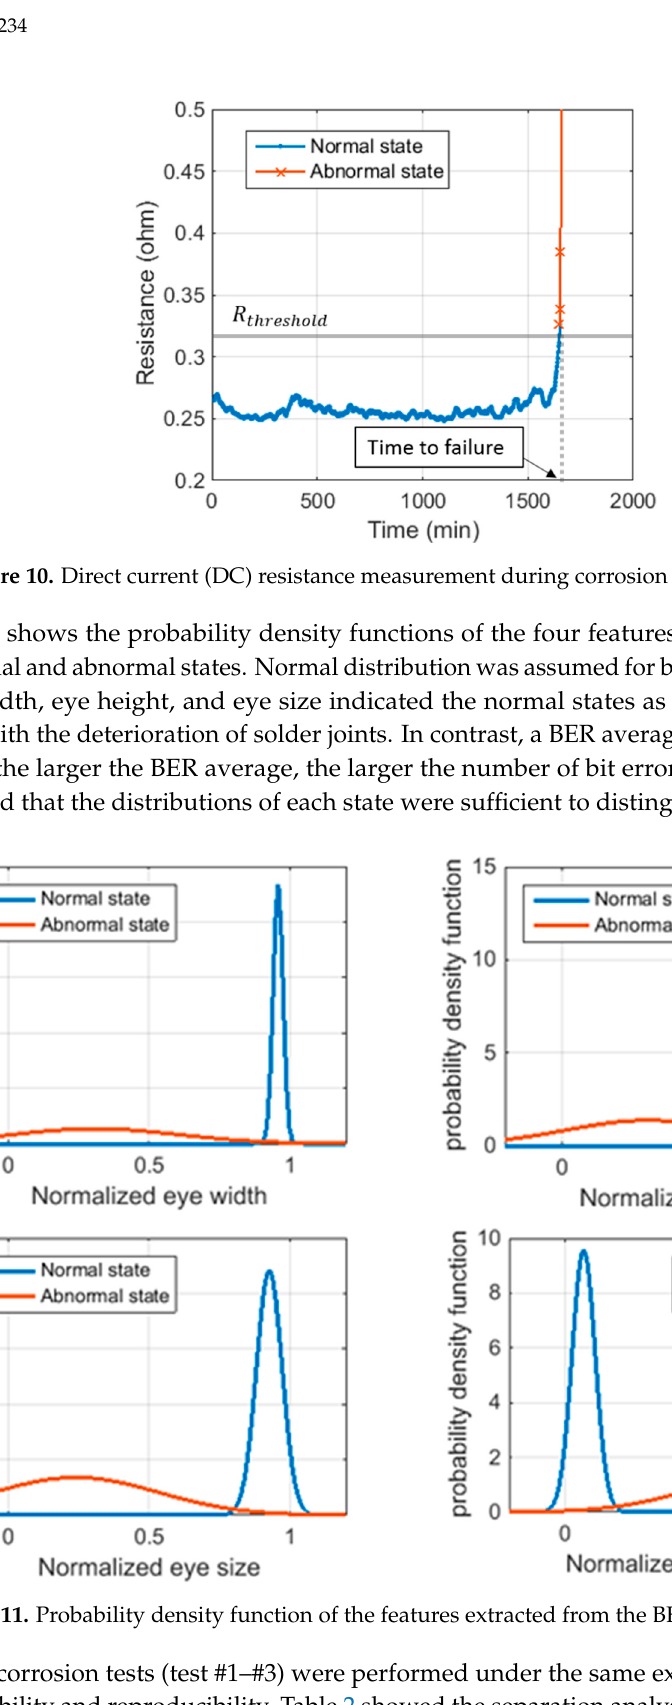
Figure 11. Probability density function of the features extracted from the BER matrix (Test #1).